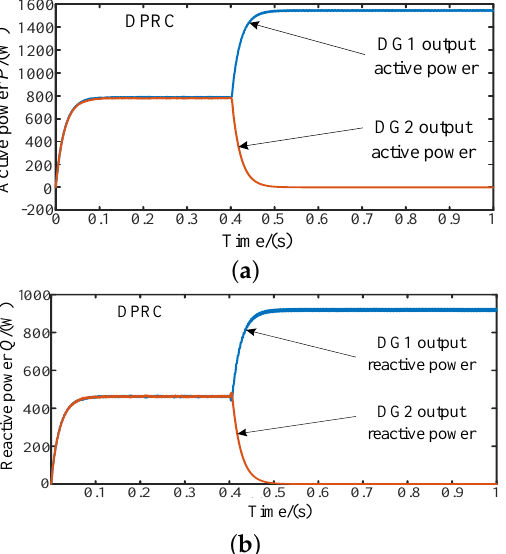
Figure 13. DG output active and reactive power. ( a ) DG output active power ( b ) DG output reactive